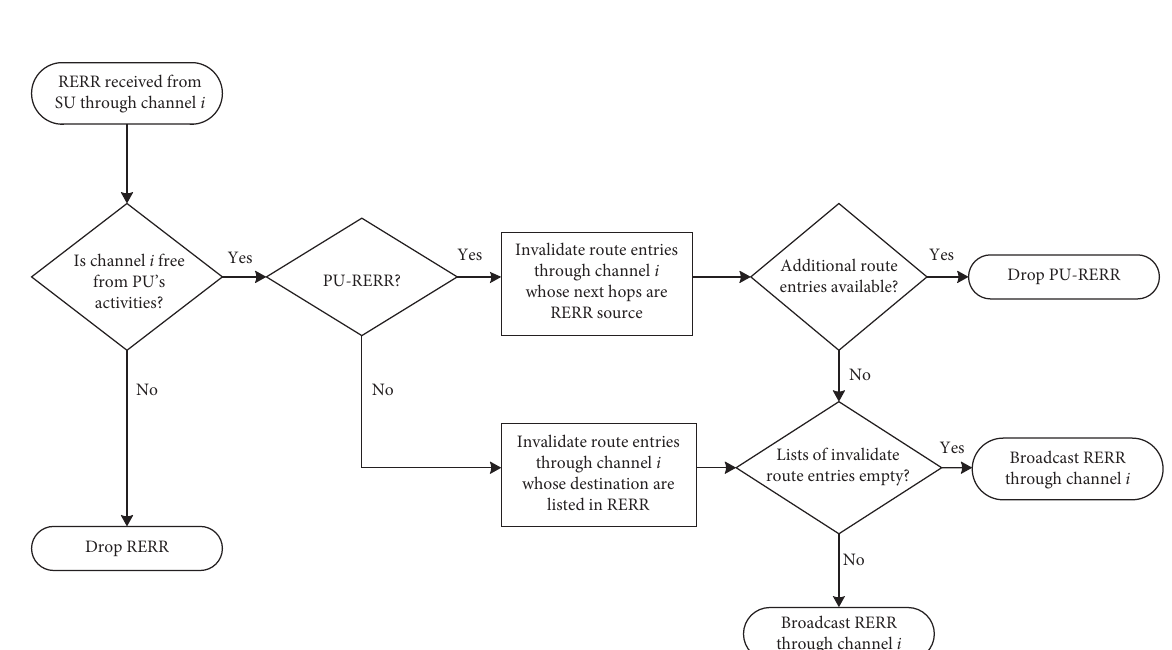
Figure 7: PU-RERR mechanism in proposed MCSUI